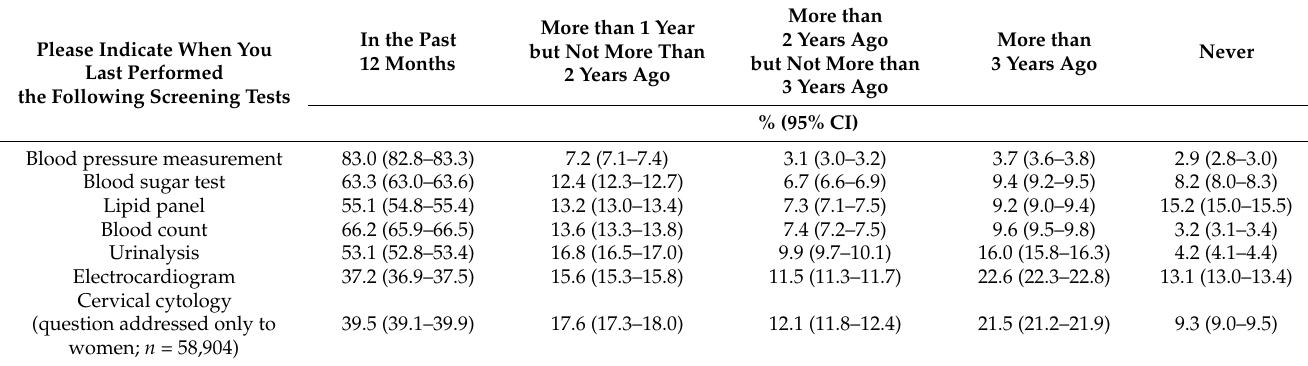
Table 2. The frequency of preventive health screening among adults in Poland ( n = 102,928).